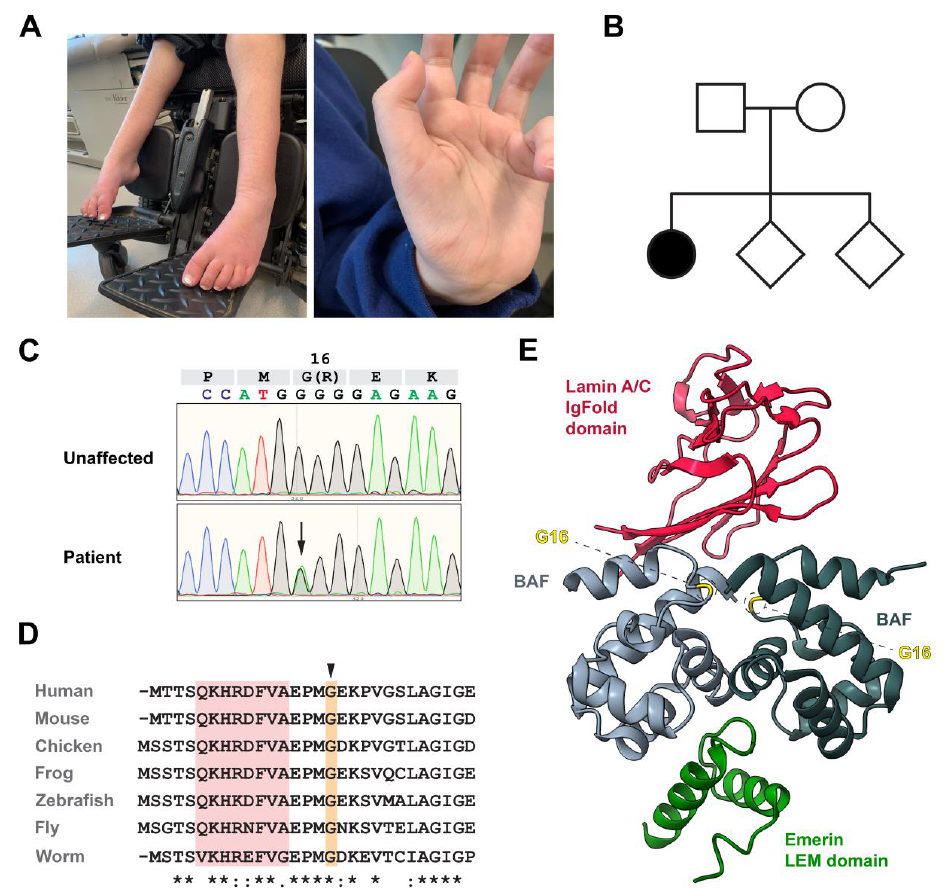
Figure 1. Identification of a de novo BANF1 mutation. ( A ) Photographs of hands and lower extremities of patient at 17 years, showing diffuse muscle weakness affecting legs. Contracture and drop of the feet are evident. Hand contractures are also observed. ( B ) Pedigree of the patient family, wherein the affected individual is shown as the black circle and unaffected individuals are shown as open shapes. ( C ) Direct sequence analysis of genomic DNA extracted from control and patient fibroblasts, confirming the heterozygous c.46G to A substitution (black arrow). ( D ) Sequence alignment of the first 28 residues of human BAF to the orthologs of the indicated species. Identical (*) and chemically similar (:) amino acids are noted below. The position of the mutated Gly is shown by the arrowhead above the alignment. The position of helix α 1 is shown by the red background. ( E ) Crystal structure of the complex between the BAF dimer (monomers shown in light and dark grey), the lamin A/C IgFold domain (red) and the emerin LEM domain (green). The position of the mutated Gly in each BAF monomer is indicated. The PDB reference of this 3D structure is